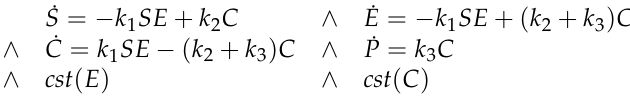
Figure 15. System of constrained equations for